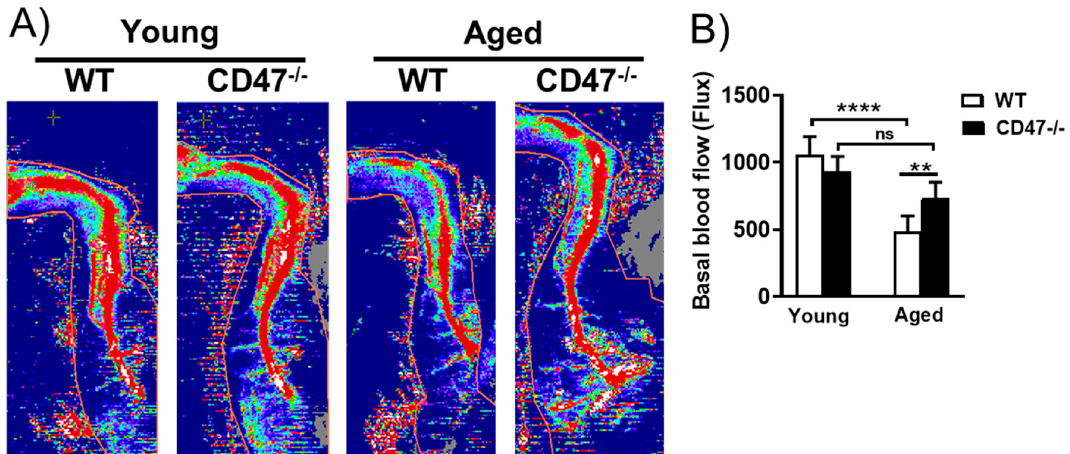
Figure 6. CD47 drives age-related deterioration of hind limb blood flow. Representative laser Doppler images and their quantification ( A , B ) of blood flow in the hind limbs of young and aged wild-type (WT) and CD47-null mice. Error bars represent the mean ± SEM. 1-way ANOVA, followed by Tukey’s multiple comparison test for blood flow measurement, 5–6 mice/group. An unpaired t -test performed with ** p < 0.01, **** p < 0.0001, ns: non-significant.